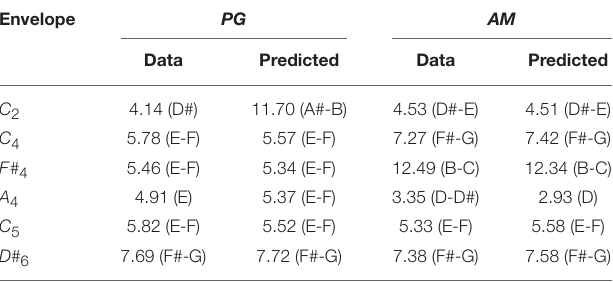
TABLE 2 | Highest Shepard tones in the data predicted by the threshold model using logistic threshold functions for PG , who showed pronounced pitch class effects and AM, who showed pronounced envelope effects for the six envelope